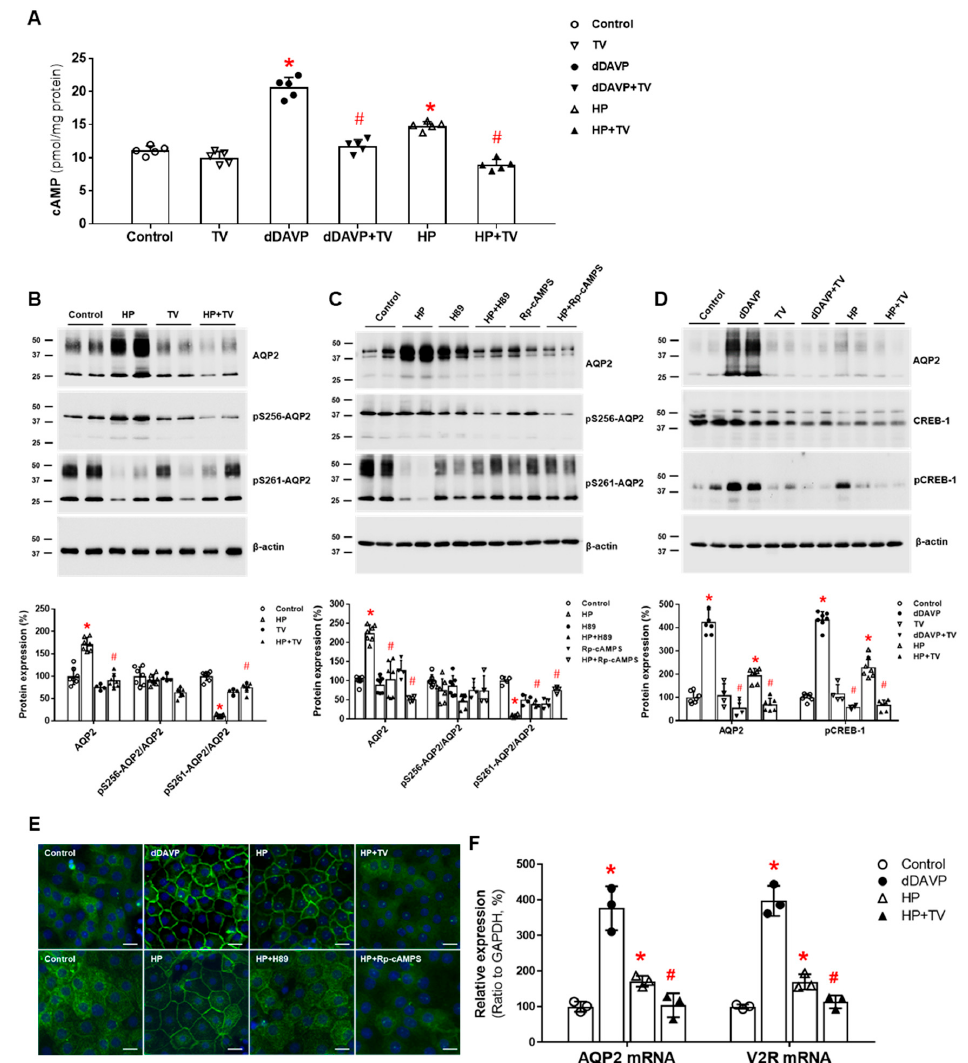
Figure 2. In vitro action of haloperidol for aquaporin-2 (AQP2) upregulation in inner medullary collecting duct (IMCD) cells . ( A ) cAMP production was measured by ELISA in IMCD suspensions after treatment with vehicle (control), 100 nM tolvaptan (TV), 10 nM 1-desamino-8-D-arginine vasopressin (dDAVP), and 5 µ M haloperidol (HP) at 37 ◦ C for 30 min. ( B ) Immunoblot analyses of total AQP2, pSer256-AQP2, and pSer261-AQP2 in primary cultured IMCD cells treated with 5 µ M HP with and without 100 nM TV for 30 min. ( C ) Immunoblot analyses of total AQP2, pSer256-AQP2, and pSer261-AQP2 in primary cultured IMCD cells treated with 5 µ M HP with and without a PKA inhibitor H89 or Rp-cAMPS. ( D ) Immunoblot analyses of total AQP2, total CREB, and pCREB-1 in primary cultured IMCD cells treated with 10 nM dDAVP and 5 µ M haloperidol (HP) with and without 100 nM TV. ( E ) Immunofluorescence microscopy for AQP2 in primary cultured IMCD cells shows that AQP2 trafficking was induced by dDAVP and haloperidol (HP) but attenuated by coadministration of TV or a PKA inhibitor. ( F ) Quantitative polymerase chain reaction data show that AQP2 and vasopressin-2 receptor (V2R) mRNA expression were increased by dDAVP and HP but reversed by TV cotreatment. Each bar represents mean ± SD. * p < 0.05 vs. control; # p < 0.05 vs. HP alone by the Mann–Whitney U-test. Adapted from Ref. [38] with permission.